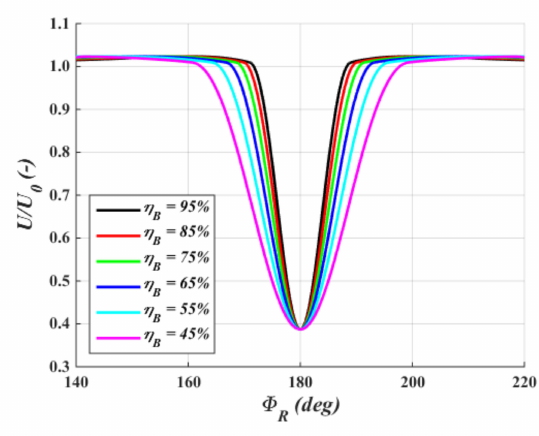
Figure 3. Tower wake wind speed distribution at x / R = 4.0, C d =